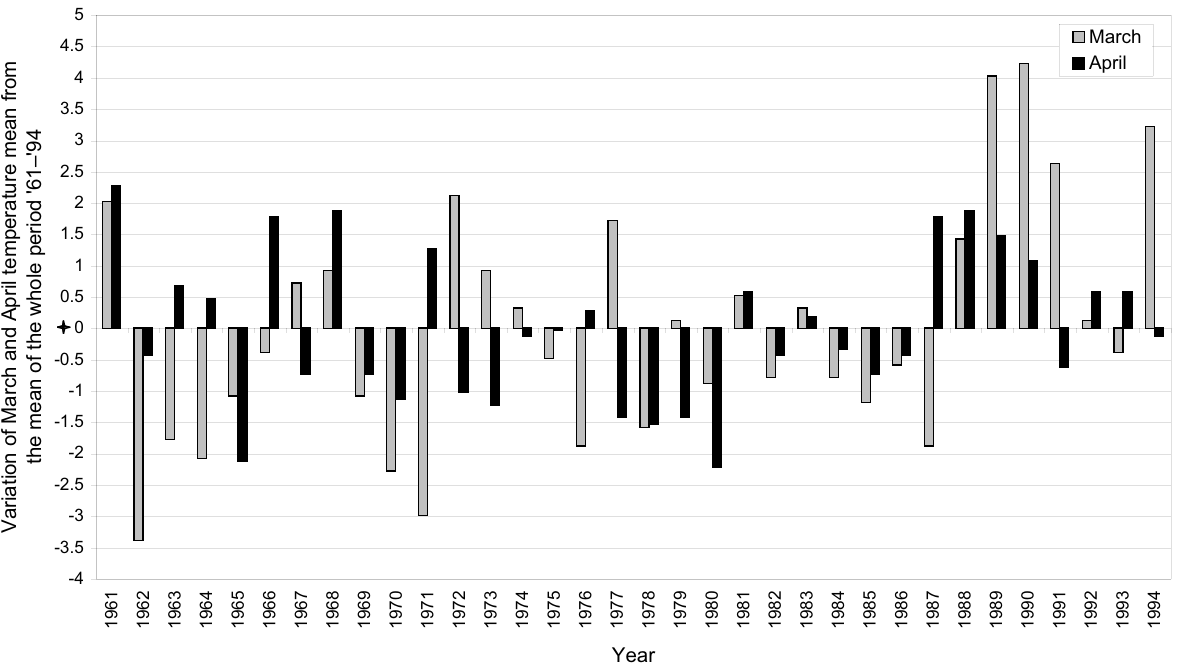
Fig. 3. Variation of the mean temperature in March and April each year from 1961 to 1994 in relation to the temper- ature mean over the whole period 1961–1994.